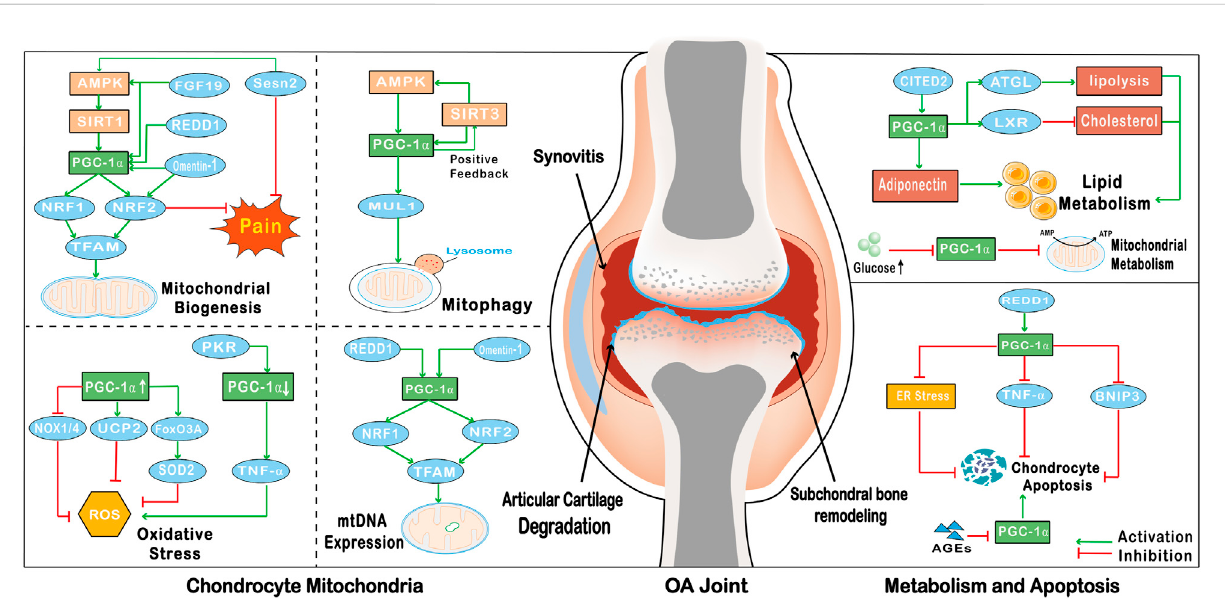
FIGURE 2 The effect of PGC-1 α on OA chondrocytes. PGC-1 α enhances the expression of NRF1, NRF2 and TFAM, and promotes the biogenesis of chondrocyte mitochondria; FGF19, REDD1 and Omentin-1 promote the biogenesis of chondrocyte mitochondria by promoting the expression of PGC- 1 α ; Sesn2 reduces the pain of OA by promoting the expression of PGC-1 α and NRF2; PGC-1 α and SIRT3 form a positive feedback loop to promote the expression of autophagy factor MUL1 to promote mitophagy; the increase of PGC-1 α expression can promote the expression of FoxO3A and UCP2 to inhibit the production of ROS; In addition, the increase of PGC-1 α can also inhibit the expression of NOX1/4 to inhibit oxidative stress; On the contrary, PKR promotes the production of TNF- α by down-regulating the expression of PGC-1 α to promote the production of ROS; REDD1 and Omentin-1 through affect the level of PGC-1 α to promote the expression of mtDNA; PGC-1 α promotes the catabolism of fatty acids and cholesterol by regulating the activity of ATGL and LXR, and CITED2 can also promote the expression of lipocalin by activating PGC-1 α to regulate chondrocyte metabolism; High levels of glucose in OA chondrocytes can down-regulate the level of PGC-1 α to inhibit mitochondrial metabolism; PGC-1 α can be activatedbyREDD1todown-regulatethelevelofin fl ammatorycytokineTNF- α toinhibitapoptosis.TheeffectofPGC-1 α oninhibitingapoptosiscanalso be realized by inhibiting ER stress. In addition, the level of PGC-1 α can be regulated by AGEs, and the decrease of PGC-1 α level in chondrocytes can activate BNIP3 to promote